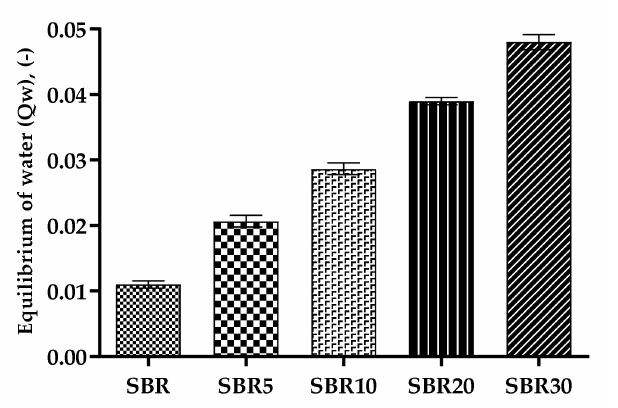
Figure 10. Equilibrium of swelling in water results from SBR vulcanizates.